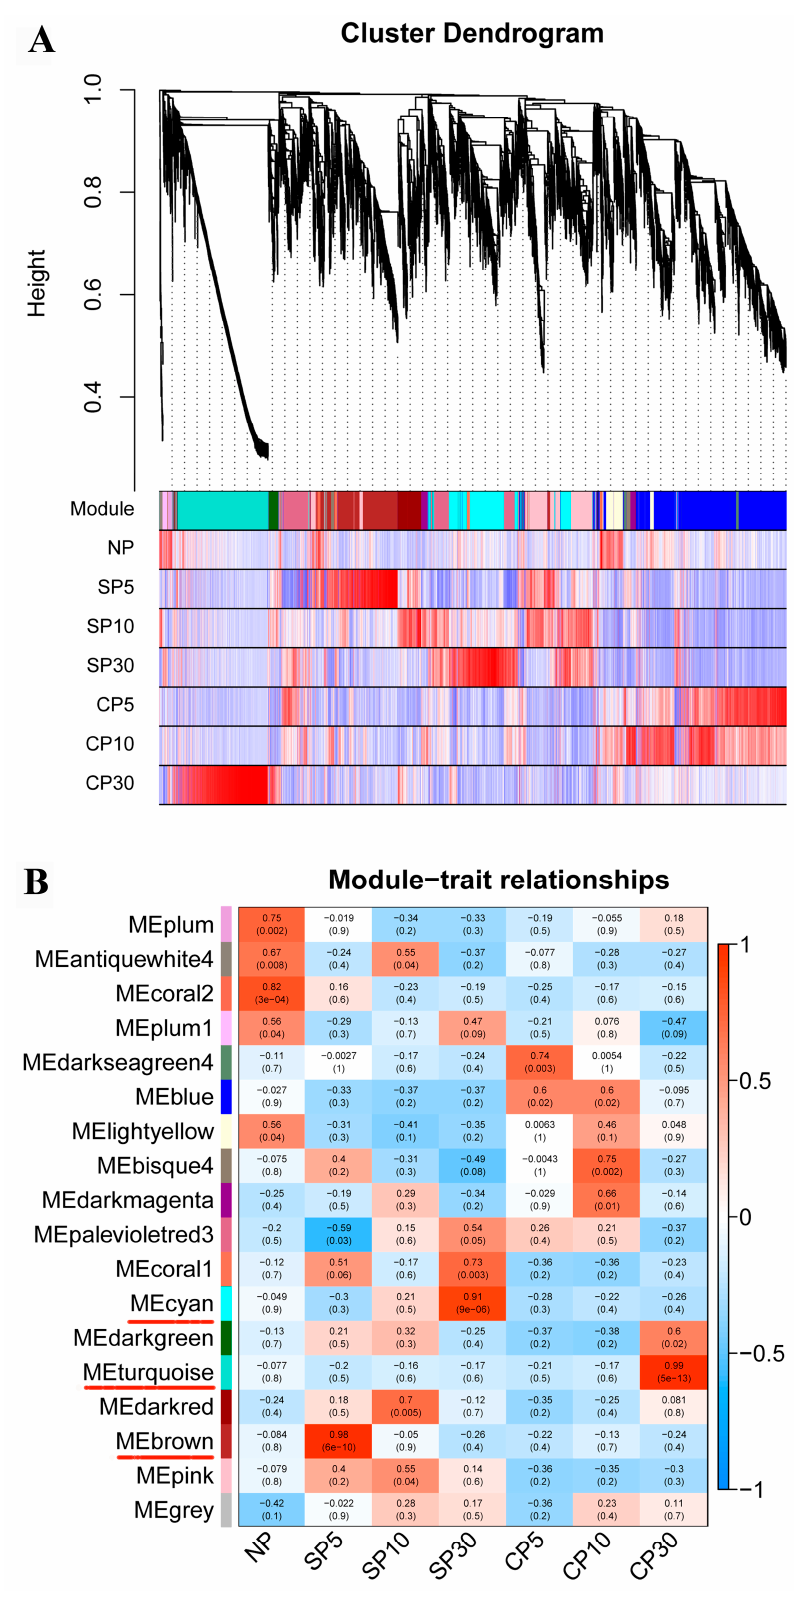
Figure 5. WGCNA of di ff erentially expressed genes (DEGs) in self- and cross-pollinated pistils over time. ( A ) Hierarchical cluster tree showing coexpression modules identified using WGCNA. Each